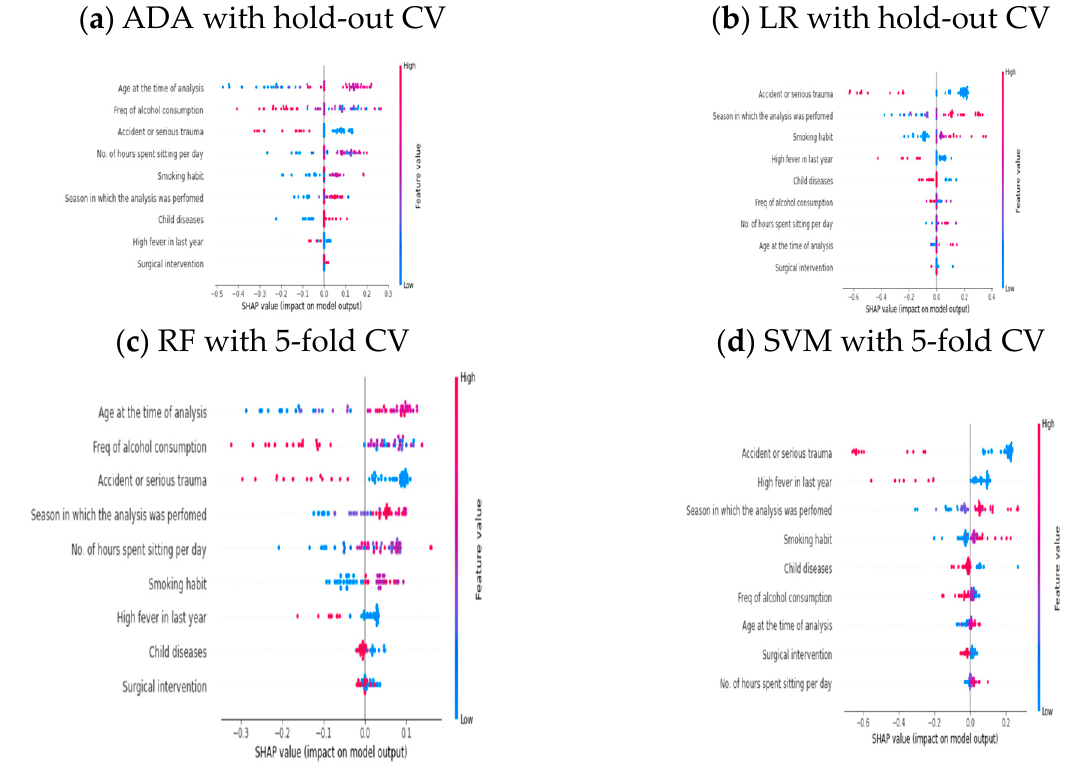
Figure 3. SHAP explanation for balance dataset.